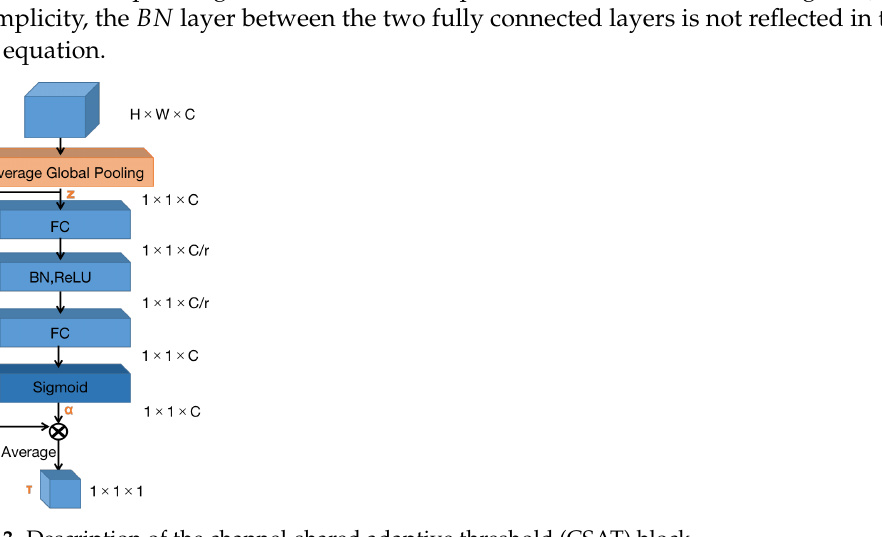
Figure 3. Description of the channel-shared adaptive threshold (CSAT)